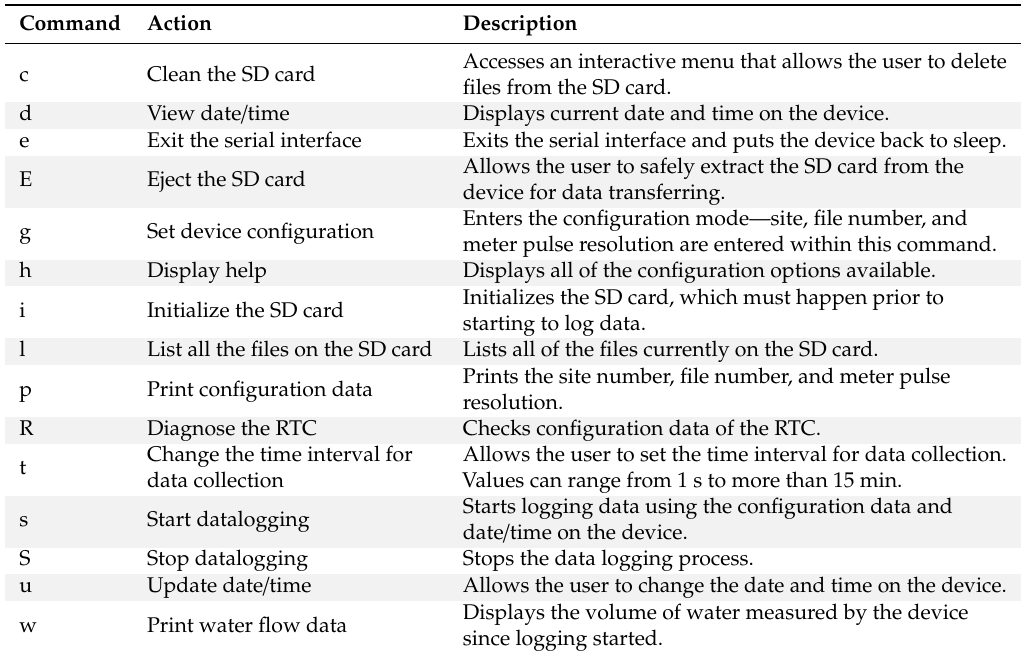
Table 4. List of commands, actions, and brief description of the main functions available in the CIWS